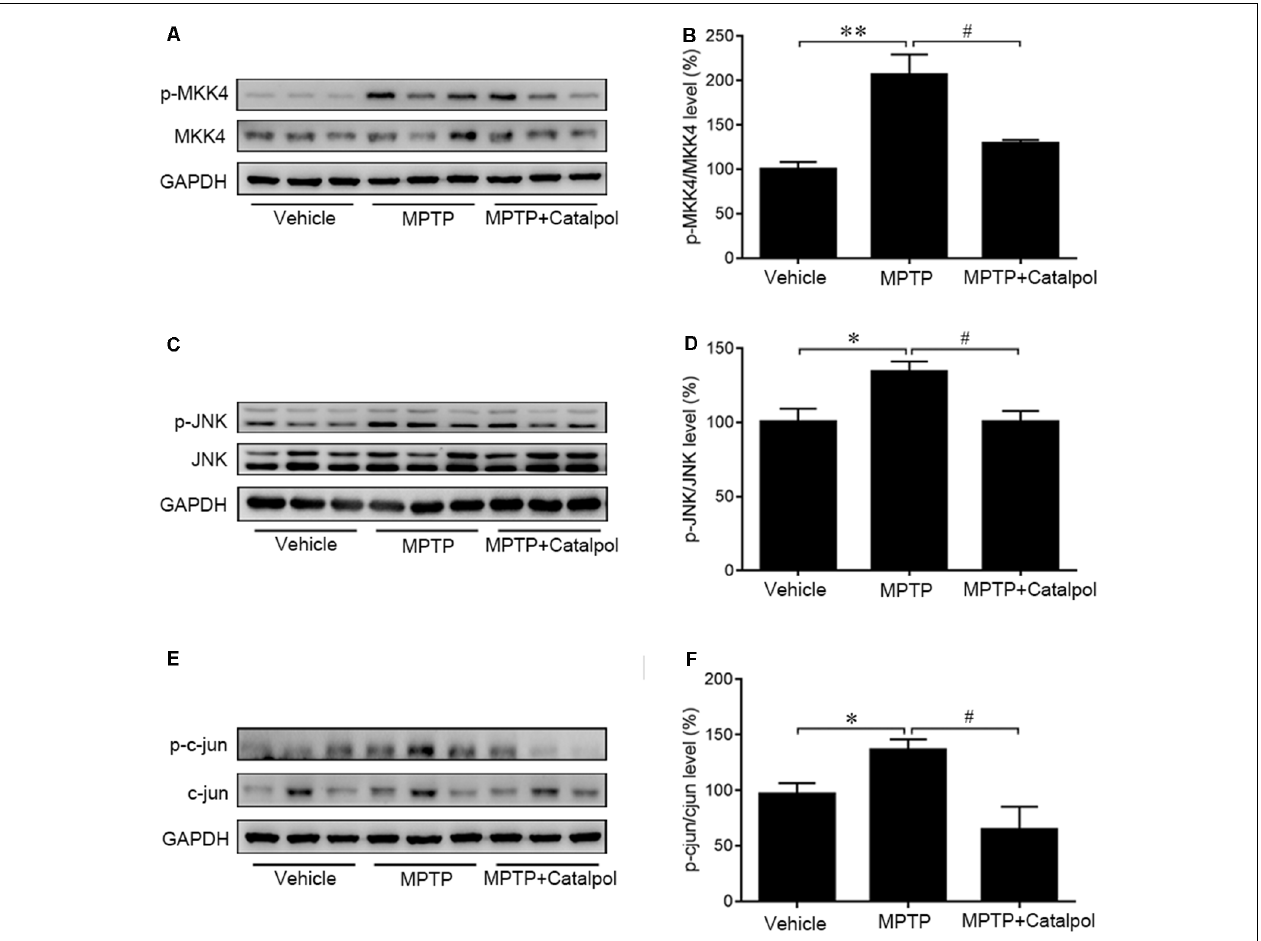
FIGURE 4 | Effects of catalpol on MKK4/JNK/c-Jun signaling in the brain of mice treated with MPTP. (A,C,E) Expression of MKK4, phosphorylated (p-) MKK4, JNK, p-JNK, c-Jun, and p-c-Jun detected by western blotting. (B,D,F) Quantitative analysis of MPTP-induced changes in protein expression and their reversal by catalpol treatment. Data represent mean ± SEM; n = 6 mice per group. The P -values were calculated using one-way ANOVA. ∗ P < 0.05, ∗∗ P < 0.01 vs. vehicle group; # P < 0.05 vs. MPTP-induced